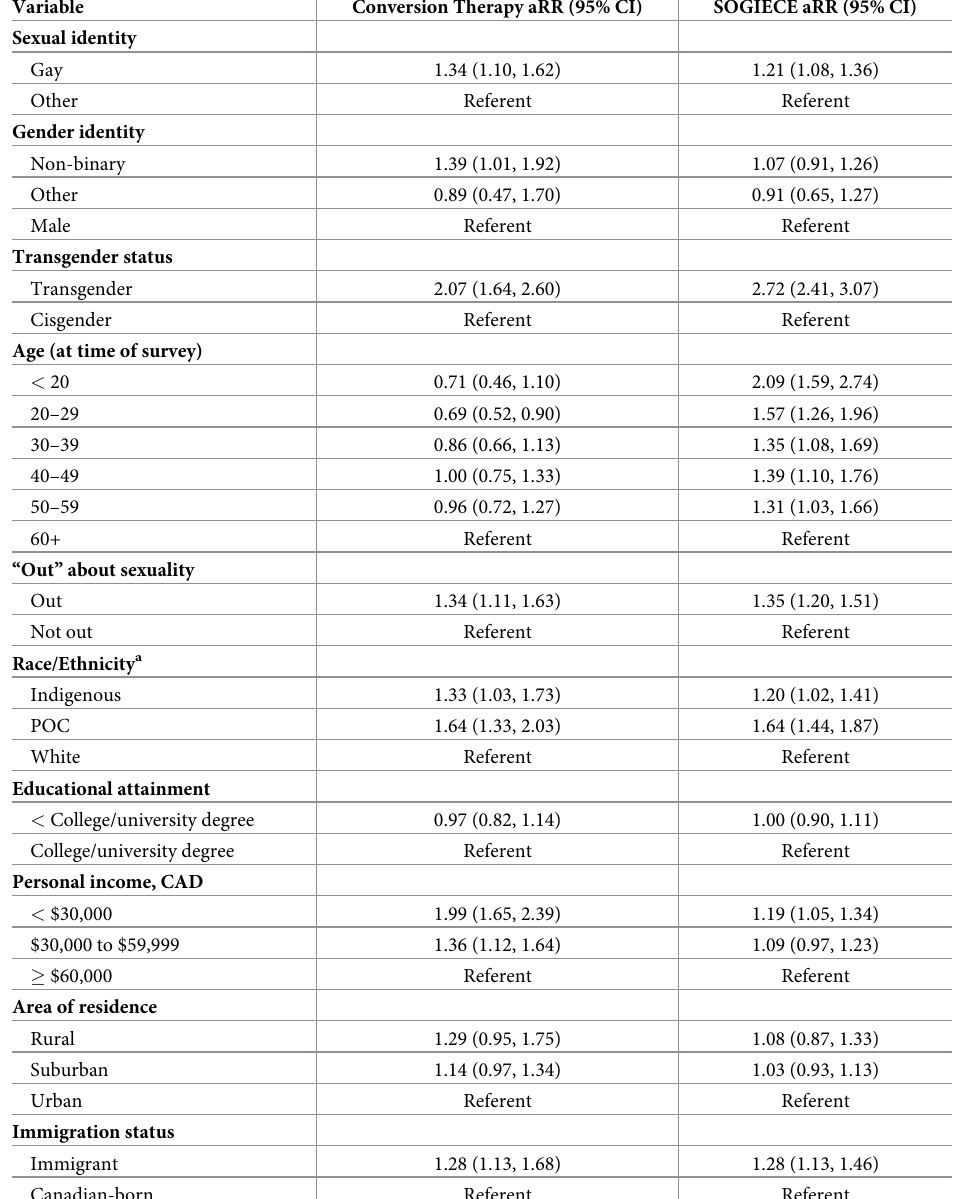
Table 3. Multivariable-adjusted associations between sociodemographic characteristics and exposure to conver- sion therapy or Sexual Orientation and Gender Identity Change Efforts (SOGIECE), among sexual and gender minority Canadian men,